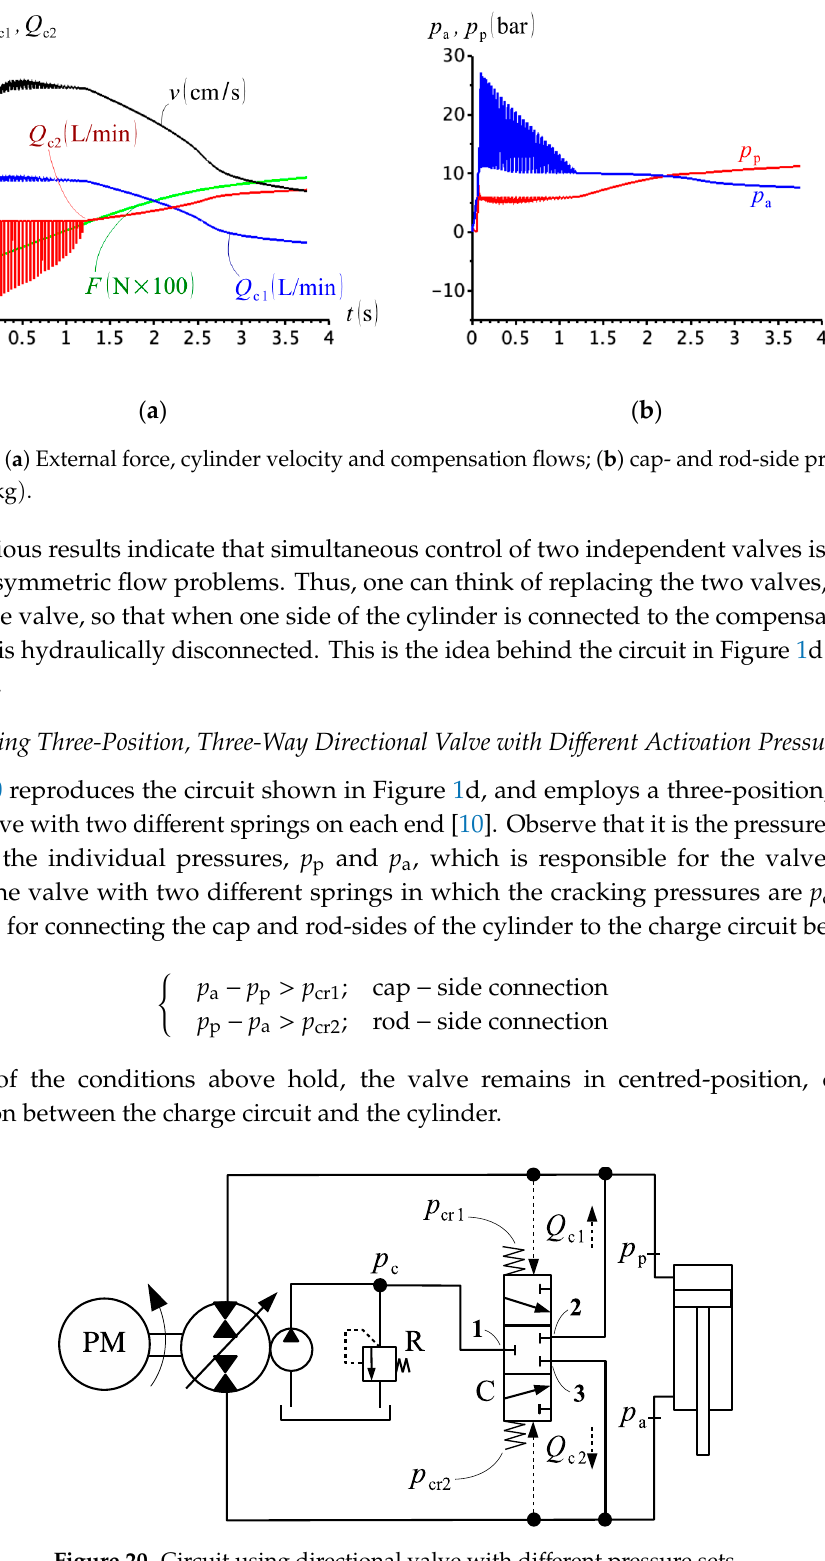
( b ) Figure 18. ( a ) Cylinder velocity and compensation flows; ( b ) cap- and rod-side pressures ((cid:1865) = 0.5 kg) .